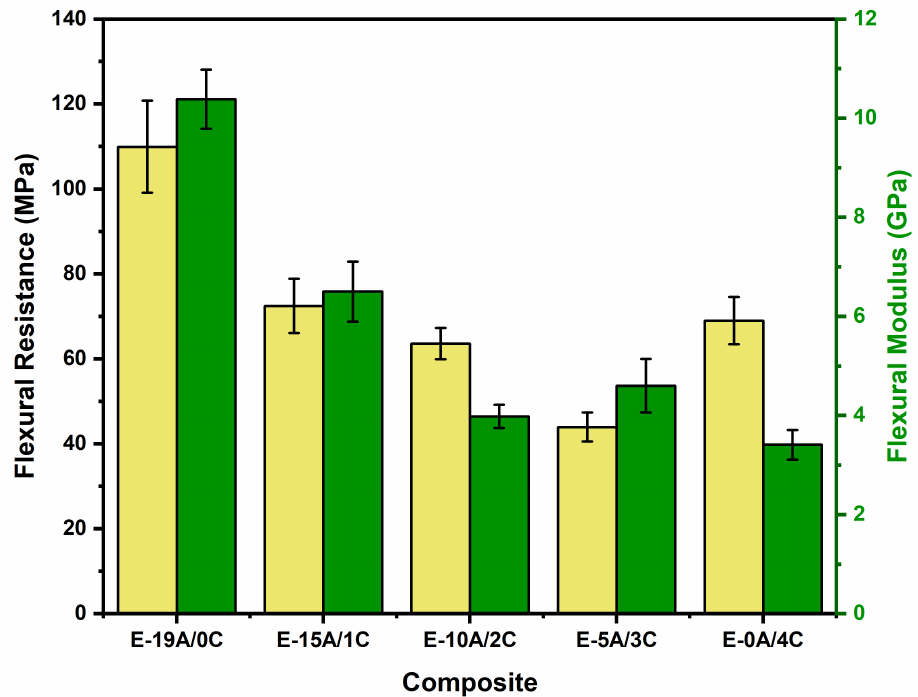
Figure 3. Comparison between flexural strength ( σ f ) and the flexural modulus ( E f ) values of hy- brid composites.